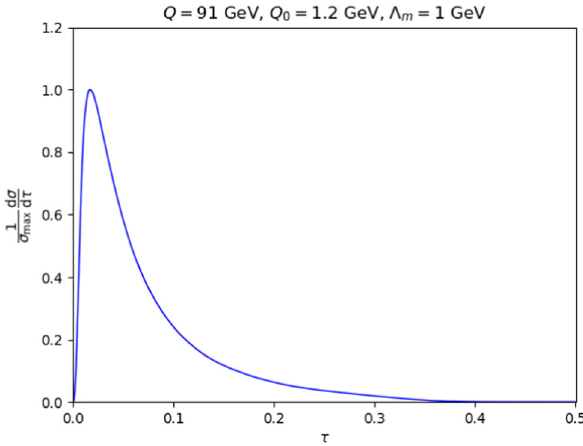
Fig. 1 Thrust distribution for the centre-of-mass energy Q = m Z , with the cutoff value Q 0 = 1 . 2GeV and the smearing parameter of the soft model shape function (cid:3) m = 1GeV. The distribution is normalized such that its peak value is